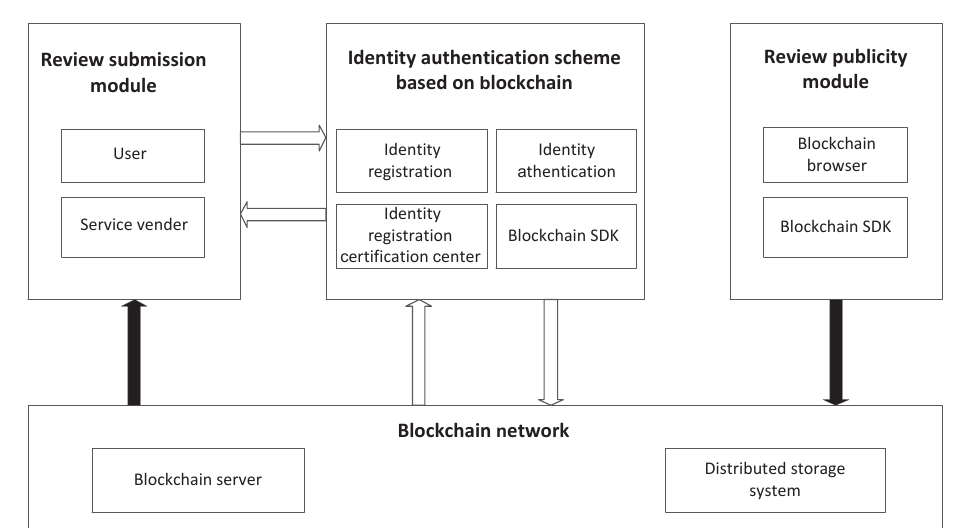
Fig. 2 Structure of the blockchain-based identity authentication scheme.